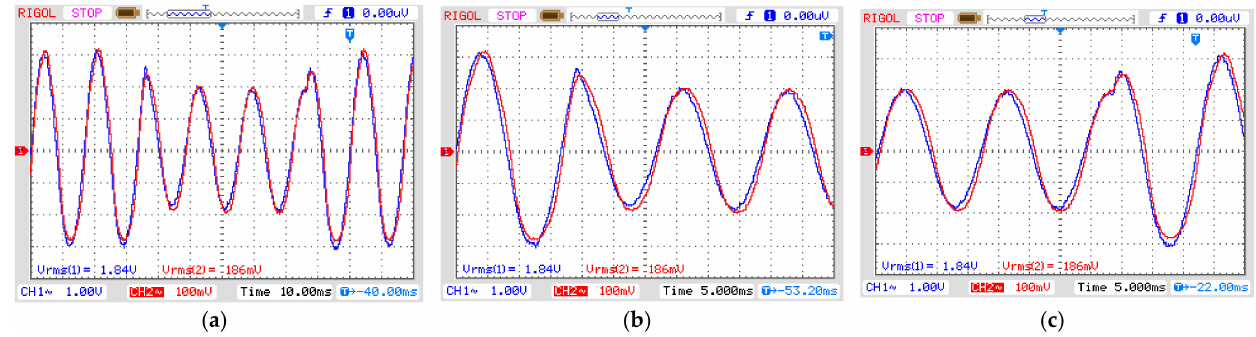
Figure 10. OVT input (CH1) and output (CH2) voltage for sag disturbance. Vertical axis: 1 V/div (CH1) and 100 mV/div (CH2). ( a ) Complete disturbance (horizontal axis: 10 ms/div); ( b ) Beginning of disturbance (horizontal axis: 5 ms/div); ( c ) End of disturbance (horizontal axis: 5 ms/div).